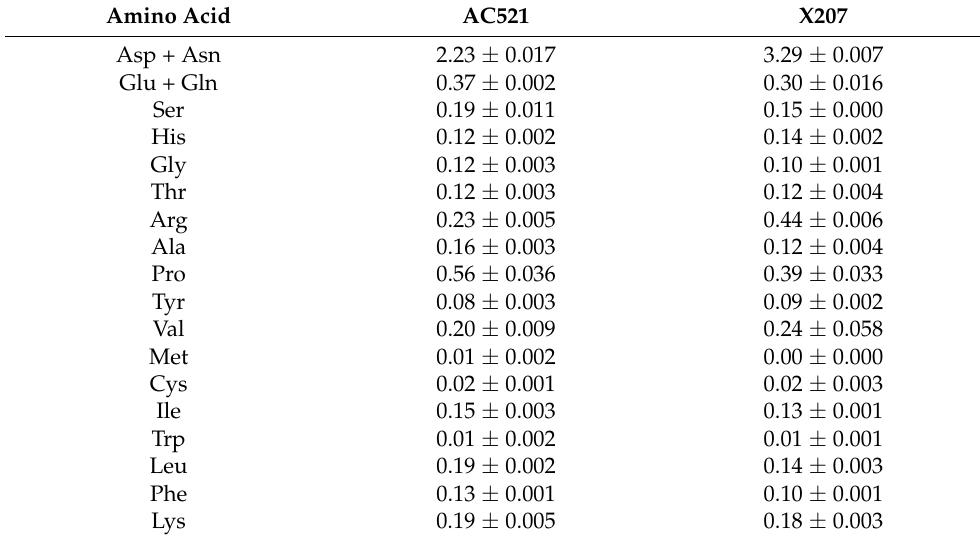
Table 5. Protein amino acids in roots of ahipa AC521 and the interspecific hybrid X207. Means in g × 100 g dry weight − 1 ± standard deviation.